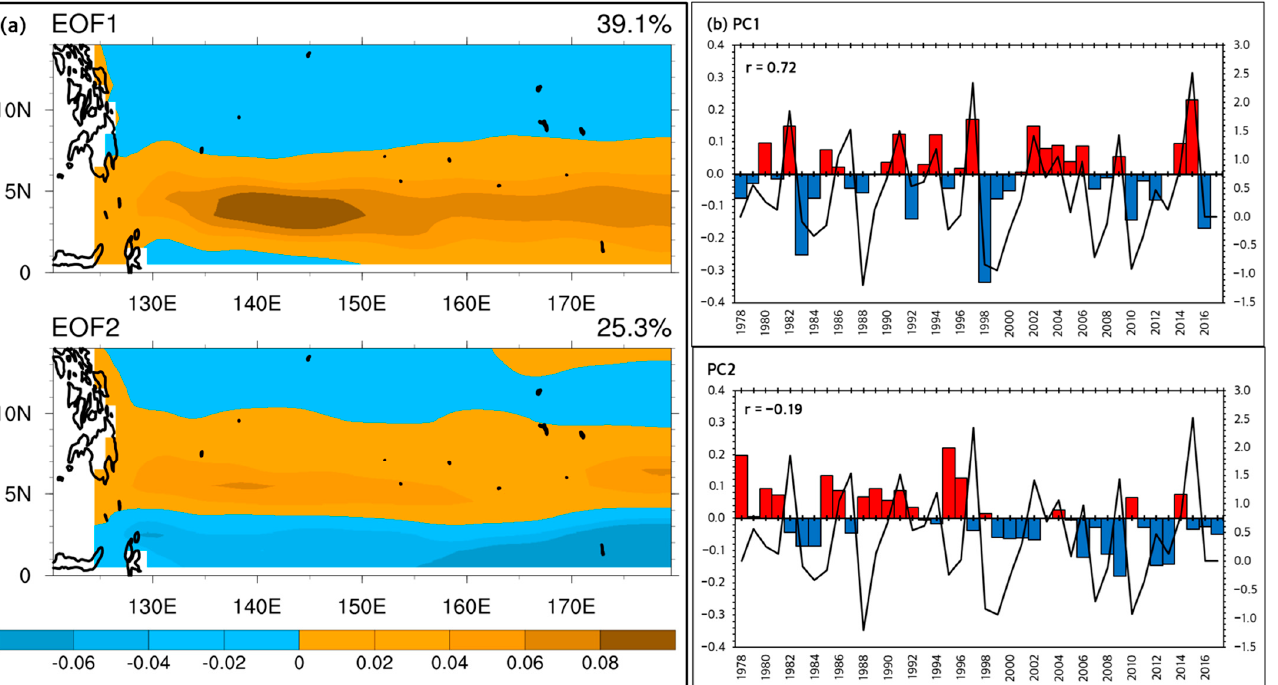
Figure 5 . The first and second EOF modes of boreal summer (JJA) zonal current geographical distribution ( a ), and associated time series PC from 1978 to 2017 overlaid with the NIÑO 3.4 indices (black line) ( b ). In ( b ), the positive and negative values denote the greater and weaker NECC mag- nitudes, respectively.